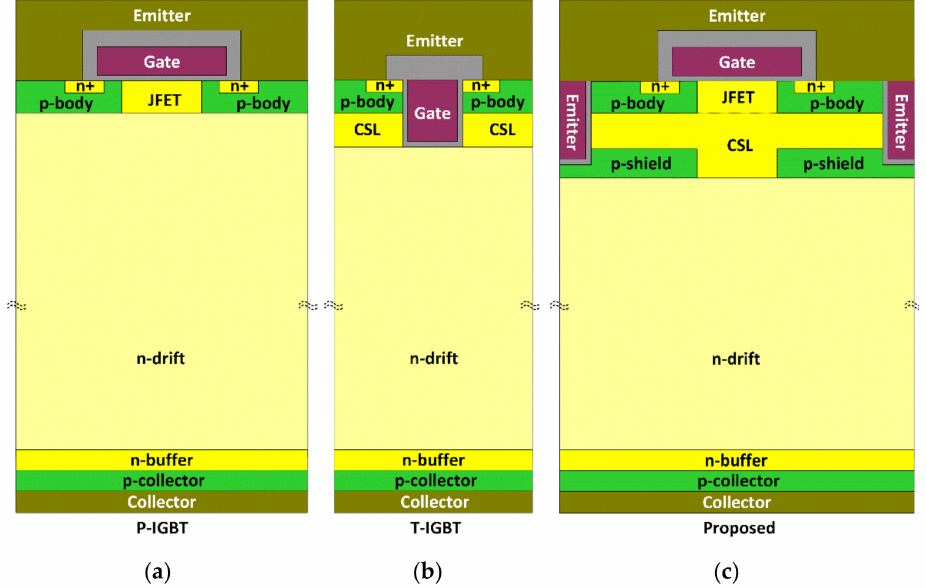
Figure 1. Schematic cross-sections of ( a ) conventional SiC planar-gate insulated-gate bipolar transistor (IGBT) (P-IGBT), ( b ) SiC trench-gate IGBT (T-IGBT), and ( c ) the proposed SiC planar-gate IGBT